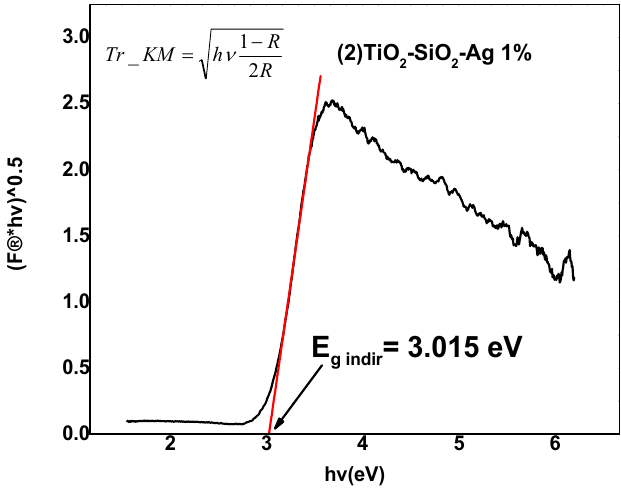
Figure A2. Kubelka-Munk transformation of reflectance spectra regarding the indirect band- gap value of (2) TiO 2 -SiO 2 -Ag